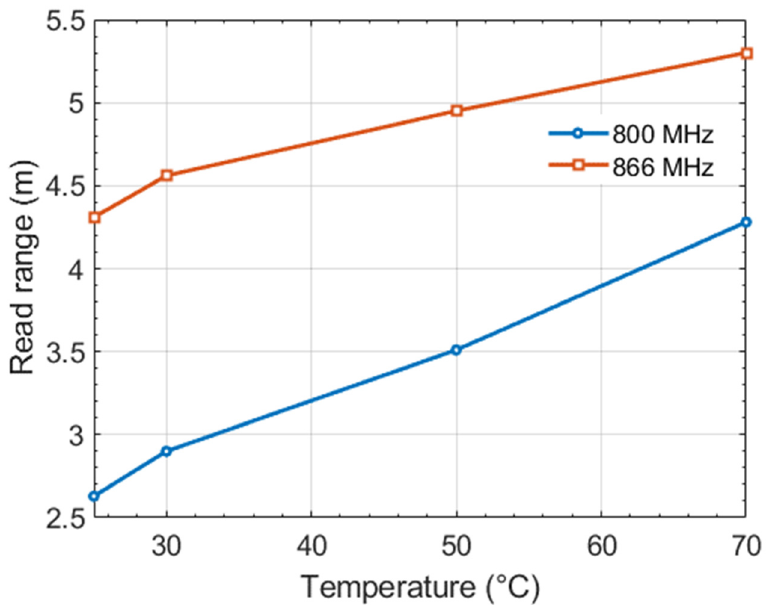
Figure 9. Impact of the temperature on the sensor’s read range.